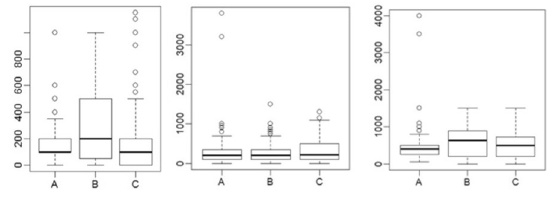
Fig. 1 Comparison boxplot between the control group (group A), the echocardiography group (group B), and the PLRT group (group C), concerning the administration of crystalloids. Here are represented data of the pre‑anesthesia phase, the post anesthesia phase and globally (pre‑ and post‑anesthesia